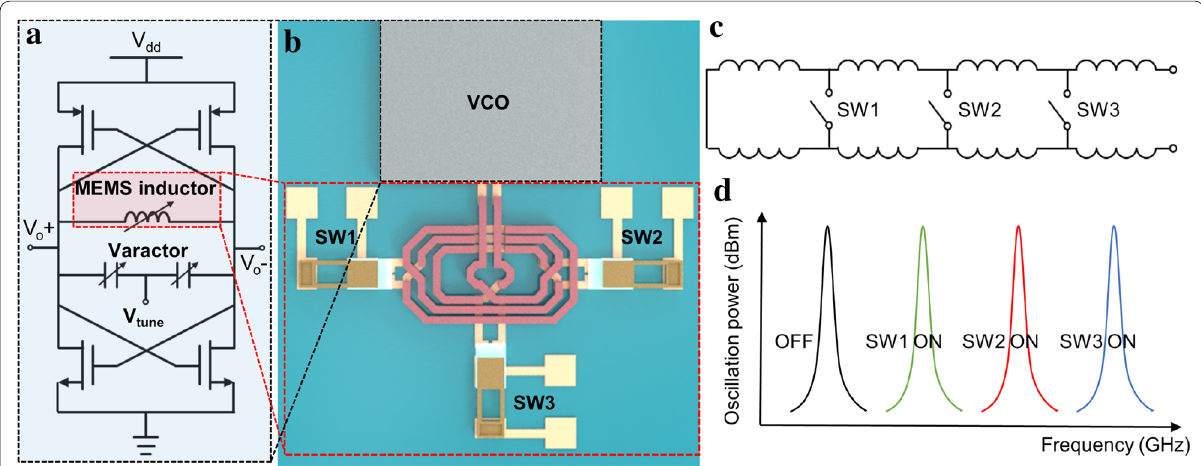
Fig. 1 Schematic illustration of the operation of the MEMS tunable inductor. a Circuit sche‑matic of a CMOS VCO integrated with the MEMS tunable inductor. b Conceptual diagram of a VCO integrated with the MEMS tunable inductor operating at four frequency bands. The effective length of the inductor changes with the switching state. c The equivalent circuit model of the MEMS tunable inductor. d Power spectrum according to the switching states of the MEMS tunable